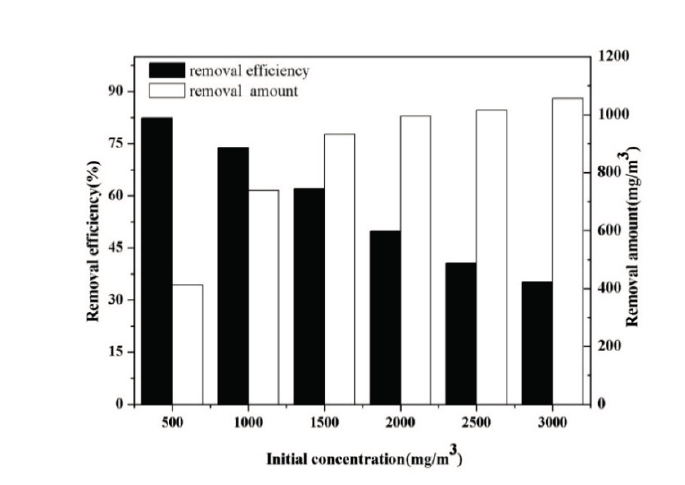
Figure 3. Influence of initial concentration on the decomposition of mixed